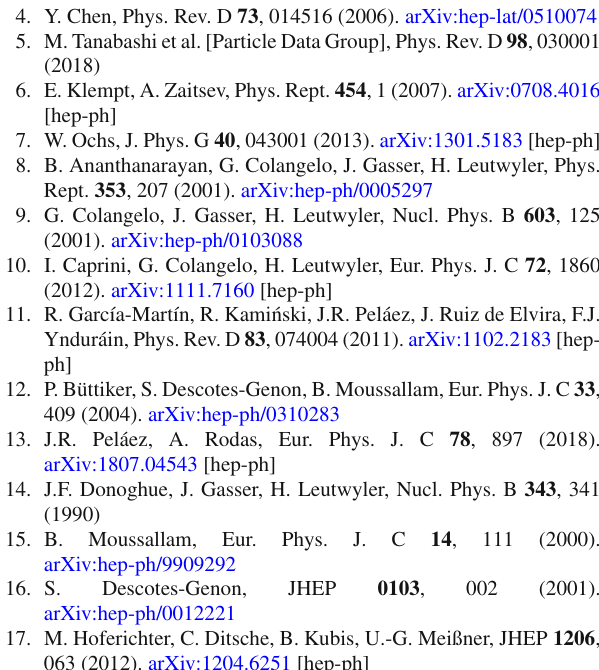
Fig. 11 Poles for the f 0 ( 500 ) (left top), f 0 ( 980 ) (right top), f 0 ( 1500 ) (left bottom), and f 0 ( 2020 ) (right bottom). We show the three fits with a σσ channel, namely Fit 1 (red), Fit 2 (green), and Fit 3 (blue), as well